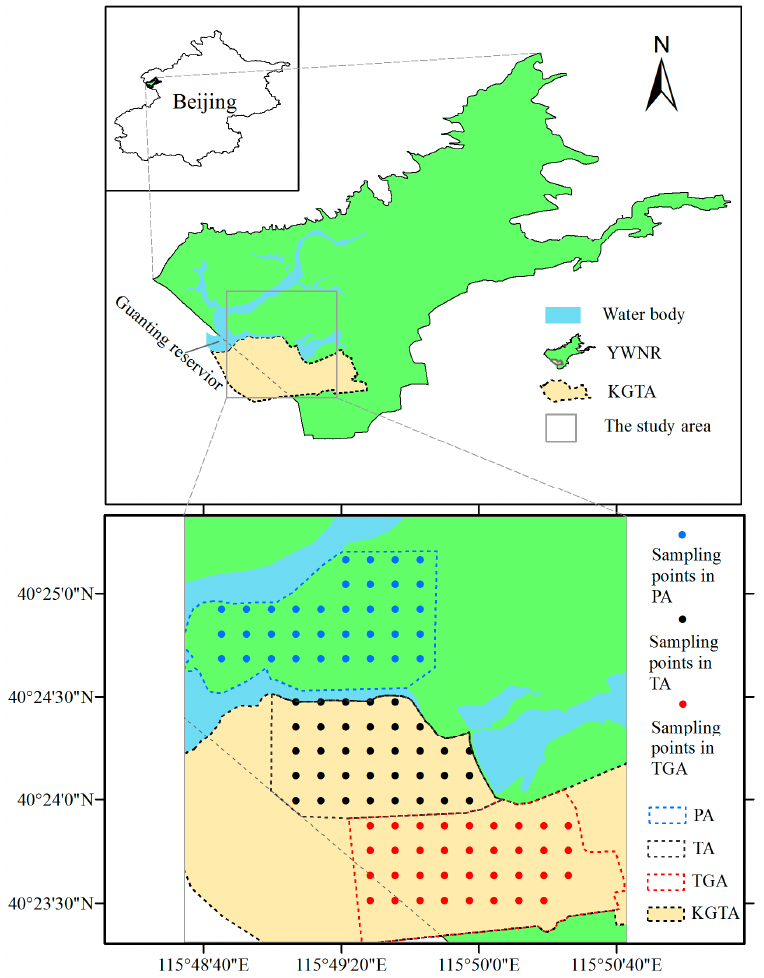
Figure 1. Location of the study area and sampling points within subareas subject to three management regimes in the Kangxi Grassland Tourist Area (KGTA) and the Yeyahu Wetland Nature Reserve (YWNR) in the Beijing Municipality. The trampled grazed area (TGA) is shown within the red dotted line. The trampled area (TA) is shown within the black dotted line. The protected area (PA) is shown within the blue dotted line. The diagonal dashed line indicates the boundary of YWNR within the KGTA.